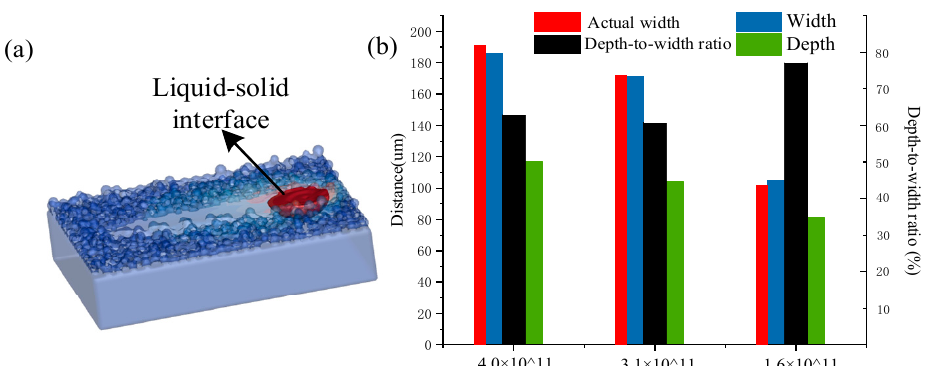
Figure 7. Molten pool data. ( a ) Molten pool shape. ( b ) Actual width of the molten pool obtained from the experiment and the width, depth, and depth-to-width ratio of the molten pool obtained from simulation.